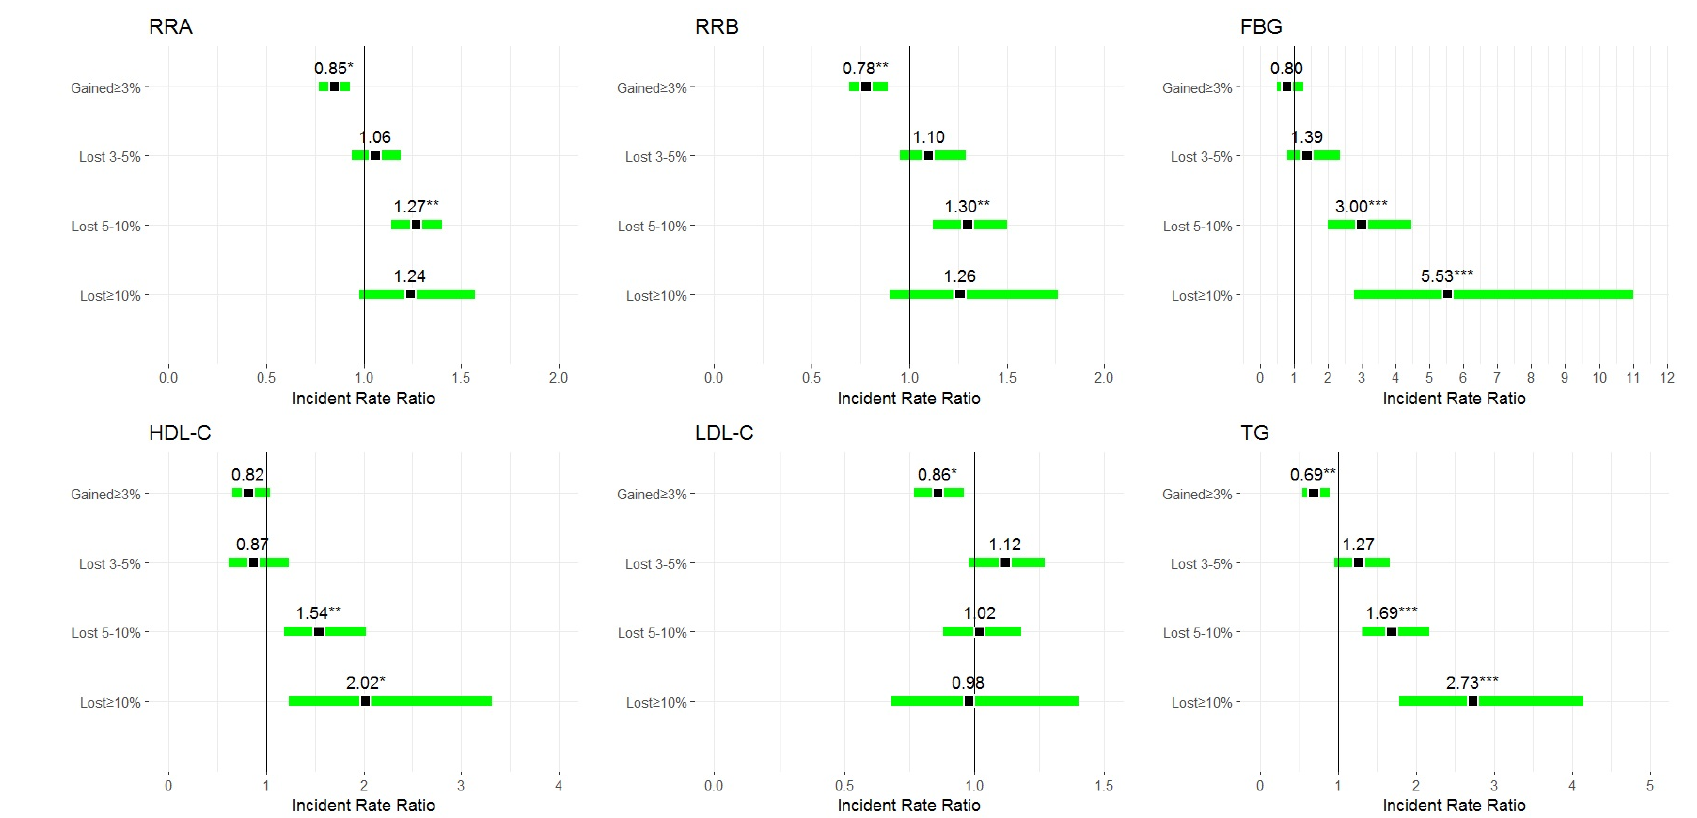
Figure 3. Adjusted incident rate ratios (IRRs) (95% CIs) of clinically significant changes in CVD risk factors associated with pertinent weight change categories. Notes: Adjustment pertains to age, gender, smoking status categorised as non-smoker (never smoker and former smoker) or smoker (current smoker); drinking status categorised as (never drinker and former drinker), or drinker (current drinker); moderate to vigorous physical activity at leisure categorised as yes or no. Abbreviations: SBP, systolic blood pressure; DBP, diastolic blood pressure; FBG, fasting blood glucose; HDL-C, high-density lipoprotein cholesterol; LDL-C, low-density lipoprotein cholesterol; TG, triglyceride. * p < 0.05; ** p < 0.01; *** p < 0.001 vs. stable category.